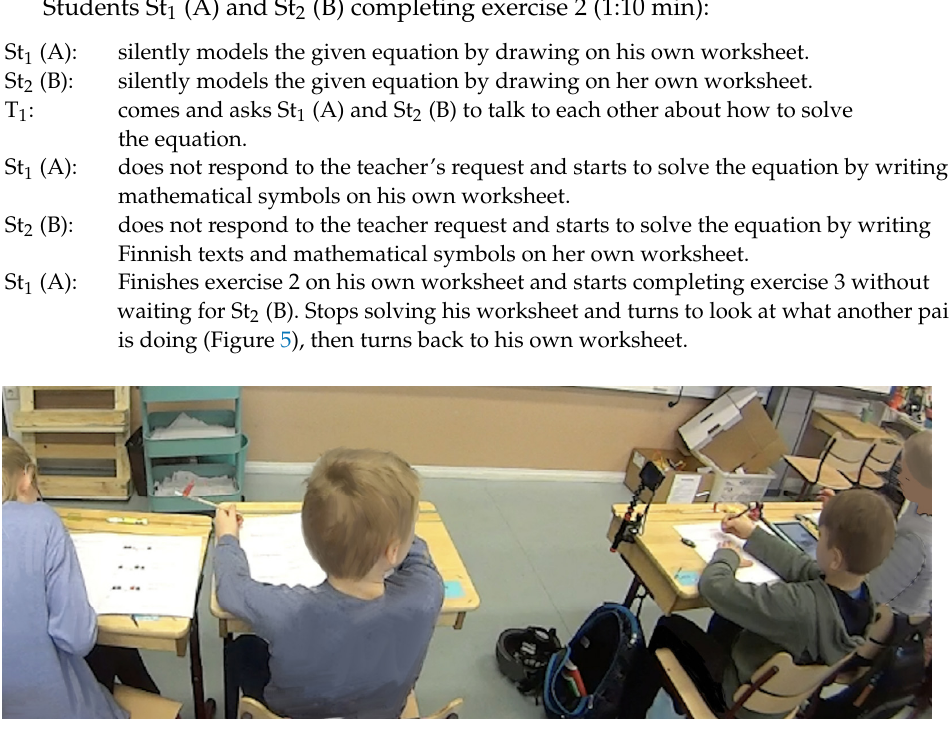
Figure 5. Lack of concentration. St 1 (A) (second from the left) turning from his worksheet to look at what the tangible-app pair is doing (on the right).